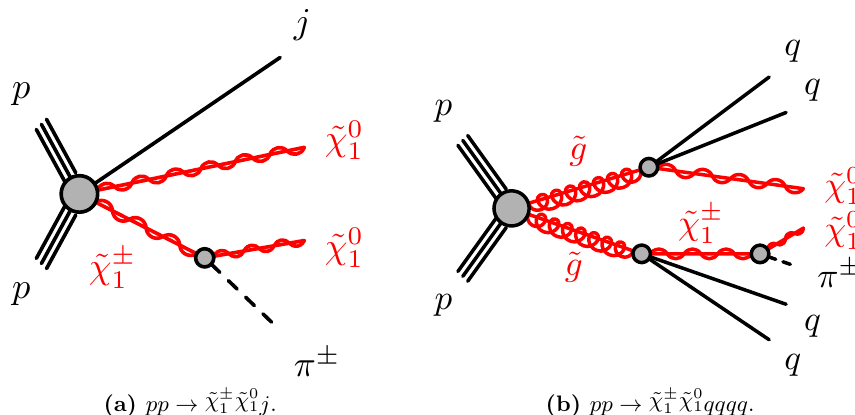
Figure 2 . Example diagrams of the benchmark signal processes used in this analysis. In the case of direct chargino/neutralino production (a), the signal signature consists of a long-lived chargino, missing transverse momentum and initial-state radiation. In the case of the strong channel (b), each gluino decays into two quarks and a chargino or neutralino. A long-lived chargino, missing transverse momentum and multiple quarks, which are observed as jets, are the signatures of this